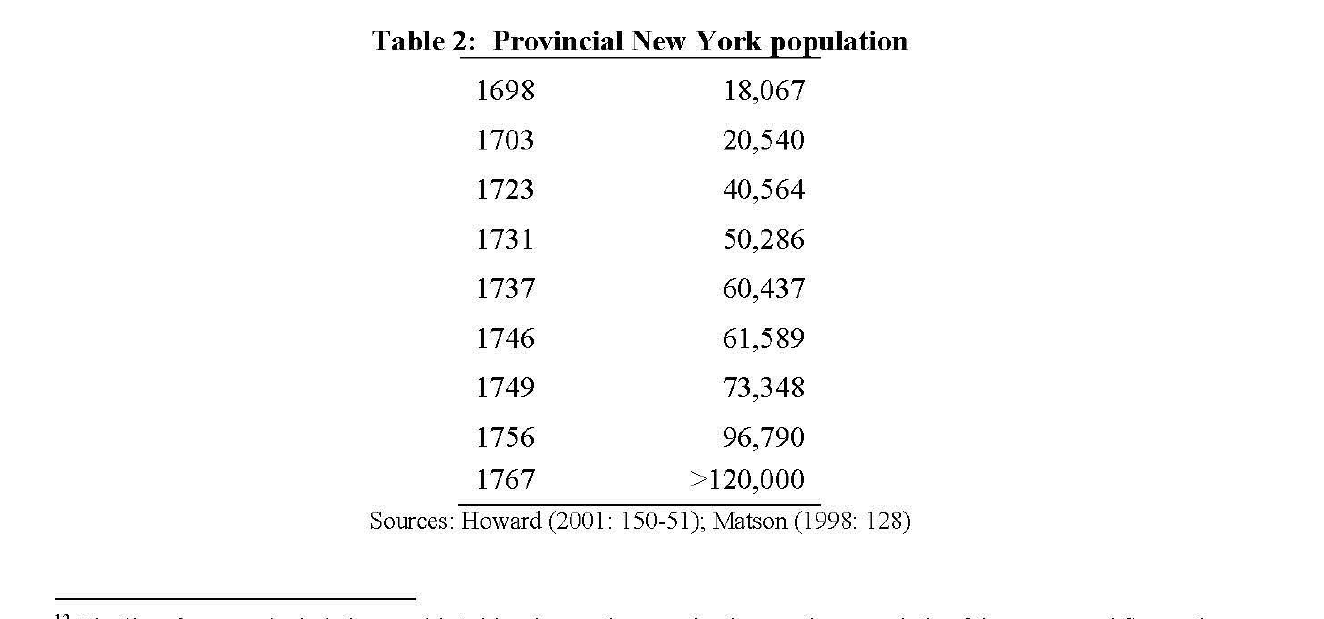
Table 2: Provincial New York